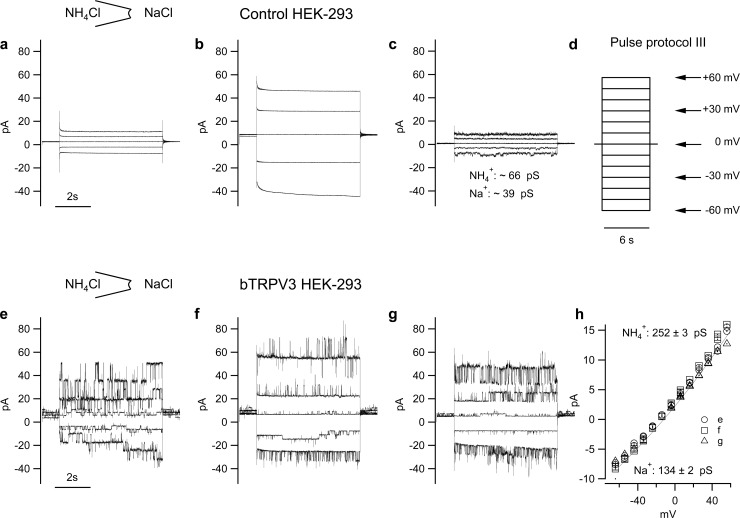
Inside-out patch-clamp measurements from control and bTRPV3 HEK-293 cells.All measurements were made with NH4Cl in the pipette and NaCl in the bath, and exposed to the pulse protocol III shown in d. For clarity, only the current responses to the pulses at –60, −30, 0, +30, and +60 mV are shown in the figures. a) patch from control cell, showing no clear sign of channel activity. b) patch from another control cell. Although no clear single-channel events can be seen, the kinetics of the currents suggest activity of very small channels. c) patch from a third control cell. Multiple peaks emerged in the amplitude histograms of some traces, suggesting single-channel activity. The conductances indicated are approximate values emerging from a GHK fit of the data. e), f), g): patches from three different cells expressing bTRPV3. Large channel events are clearly visible in NaCl bath solution both at negative potentials (reflecting influx of Na+ through channels into the pipette) and at positive potentials (reflecting efflux of NH4+). h) IV-Plot of the single-channel currents in (e (○), f(□) and g (△)), jointly fitted to the Goldman-Hodgkin-Katz equation and yielding the conductance indicated.